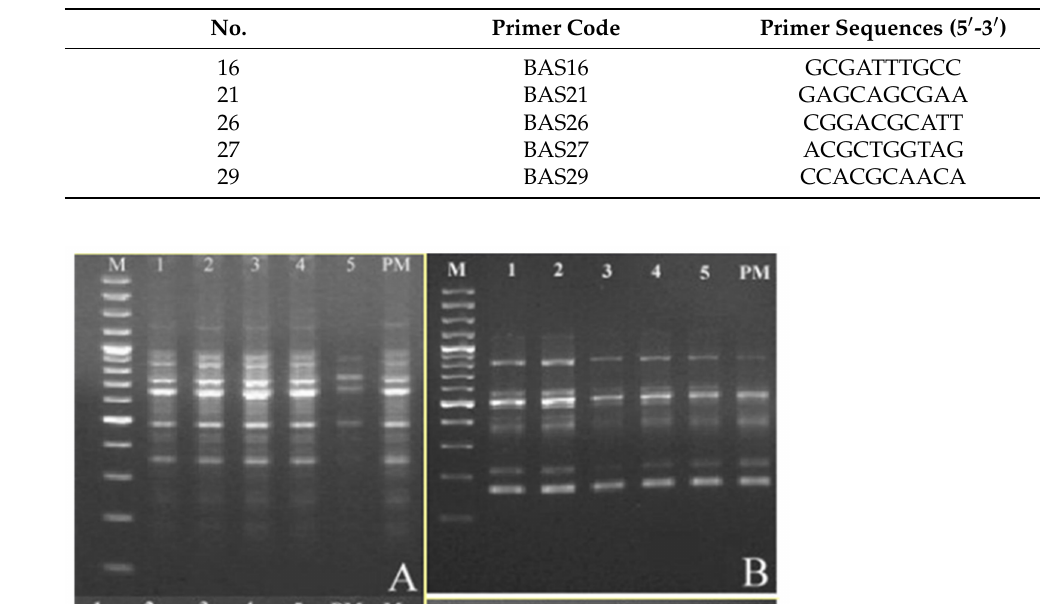
Table 3. List of primers, codes, and sequences (5 (cid:48) -3 (cid:48) ) of the amplified fragments generated by five out of the 31 randomly amplified polymorphic DNA (RAPD) markers employed to assess the genetic stability of Tetraclinis articulata (Vahl) Masters microplants.